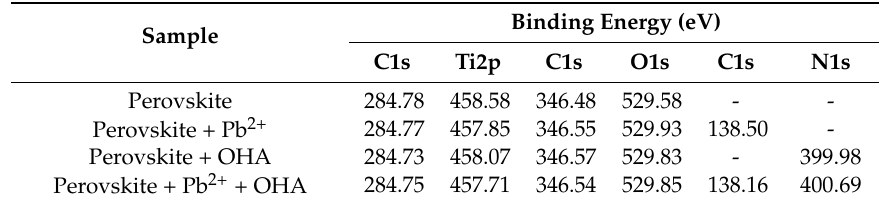
Table 3. Binding energies of elements on the perovskite surface.